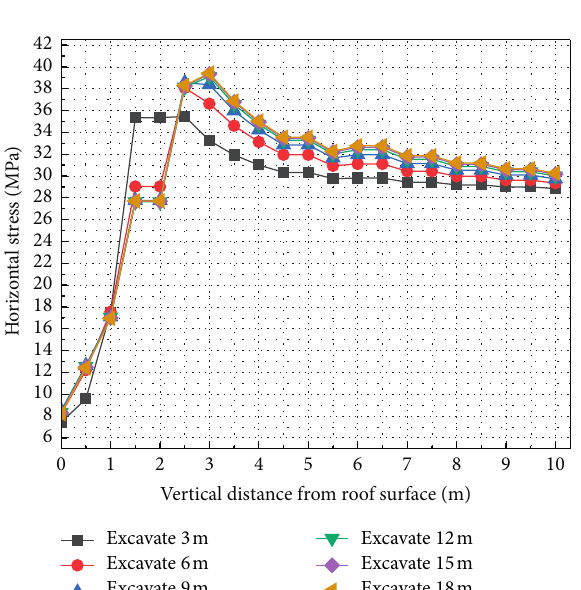
Figure 5: Horizontal stress distribution under different excavation distance.